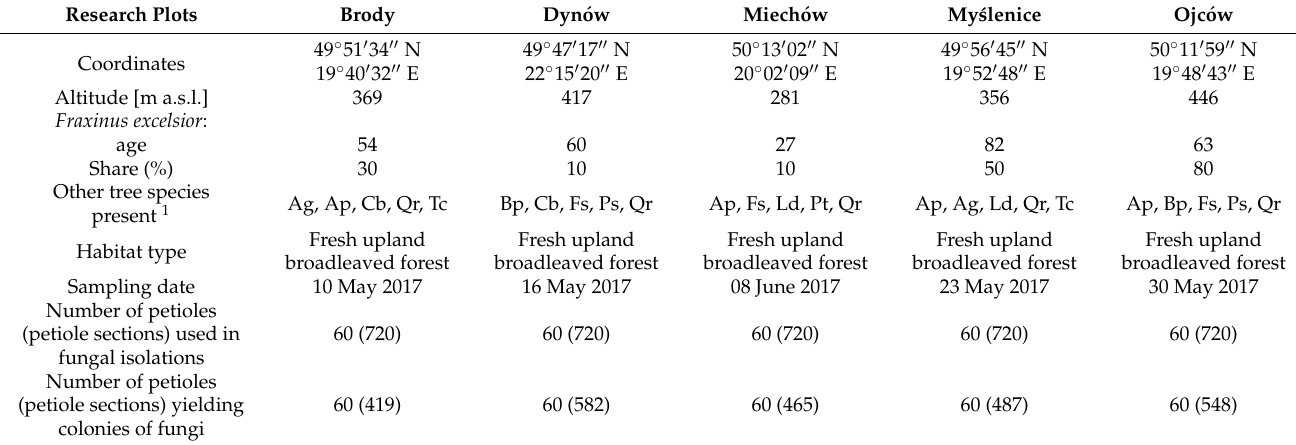
Table 1. Sampling sites and number of leaf petioles of F. excelsior from the previous year analyzed in the study. Research